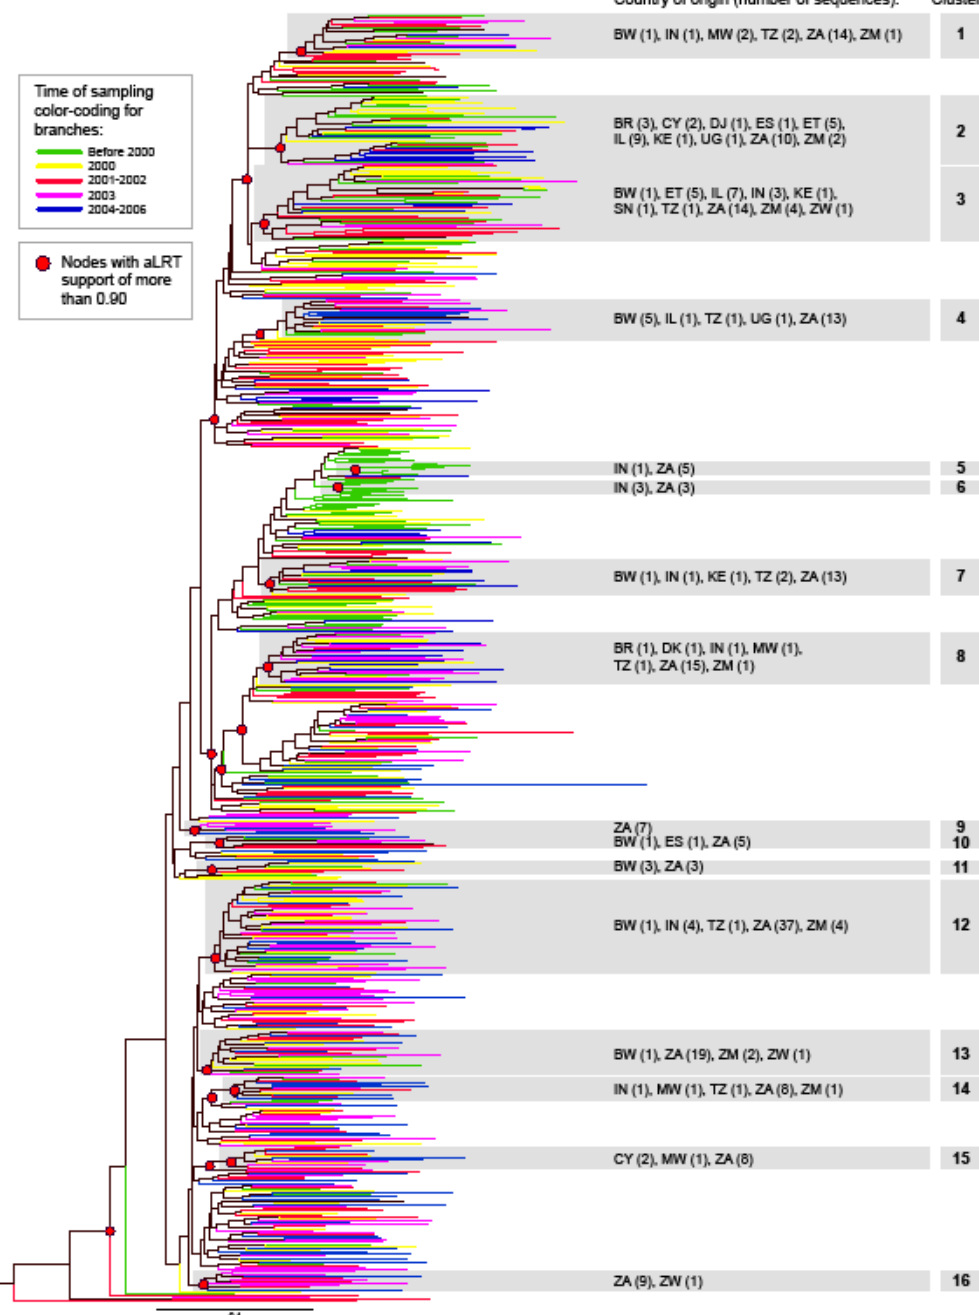
Figure 1. Phylogenetic relationships between HIV-1 subtype C gag